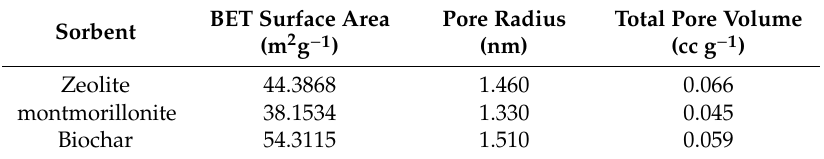
Table 1. The values of surface area, pore volume, and pore radius for each investigated adsorbent. BET Surface Area Pore Radius Total Pore Volume Sorbent (m 2 g − 1 ) (nm) (cc g − 1 ) Zeolite 44.3868 1.460 0.066